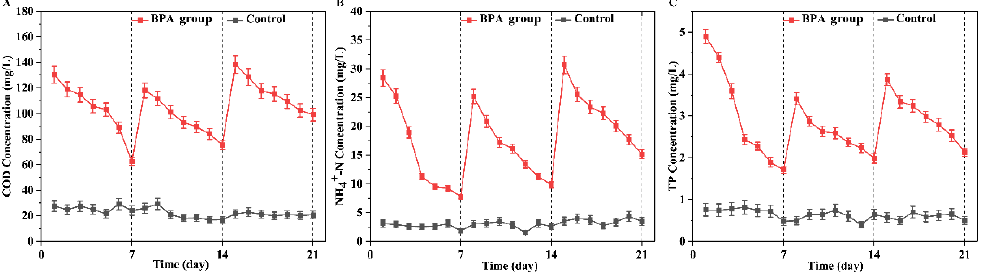
Figure 2. Effect of bisphenol A (BPA) on sequencing batch reactor (SBR) water quality. ( A ) COD; ( B ) Ammonia nitrogen; ( C ) Total phosphorus.